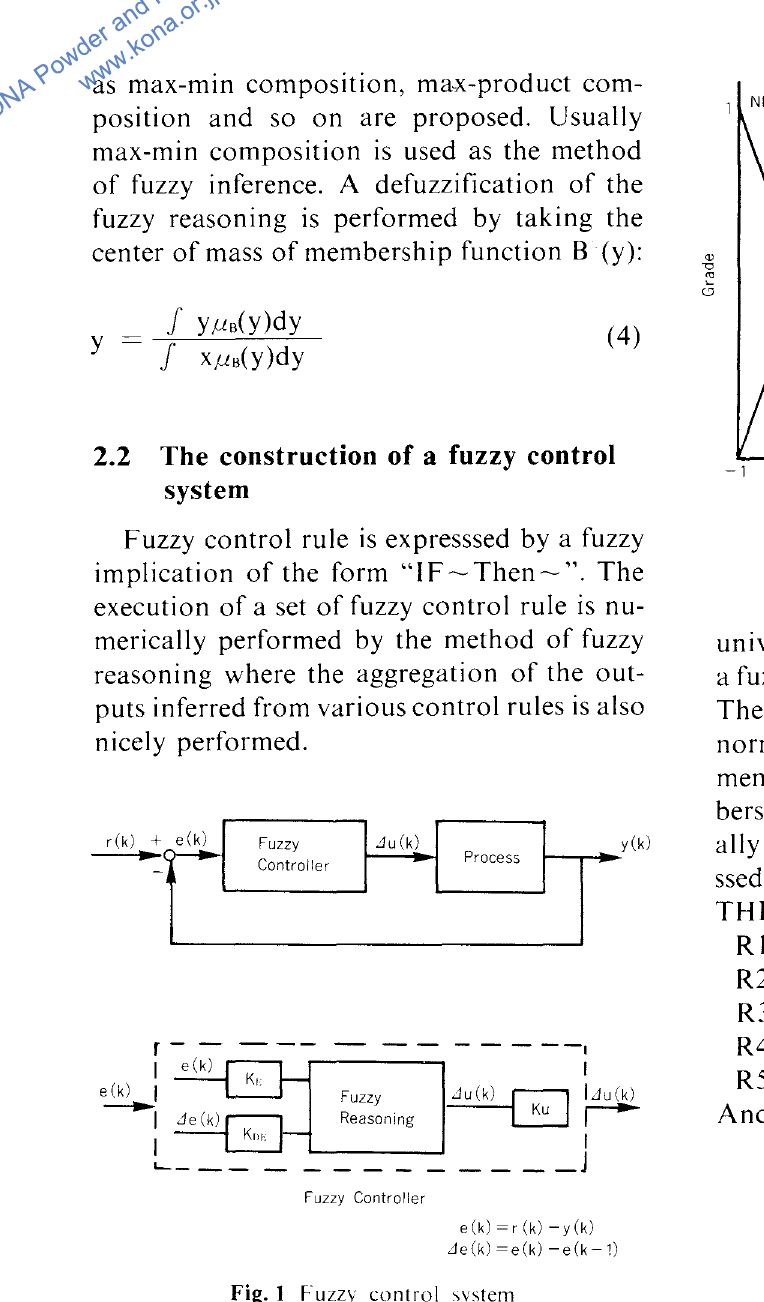
Fig. I Fuzzy control -.,y-.,tem